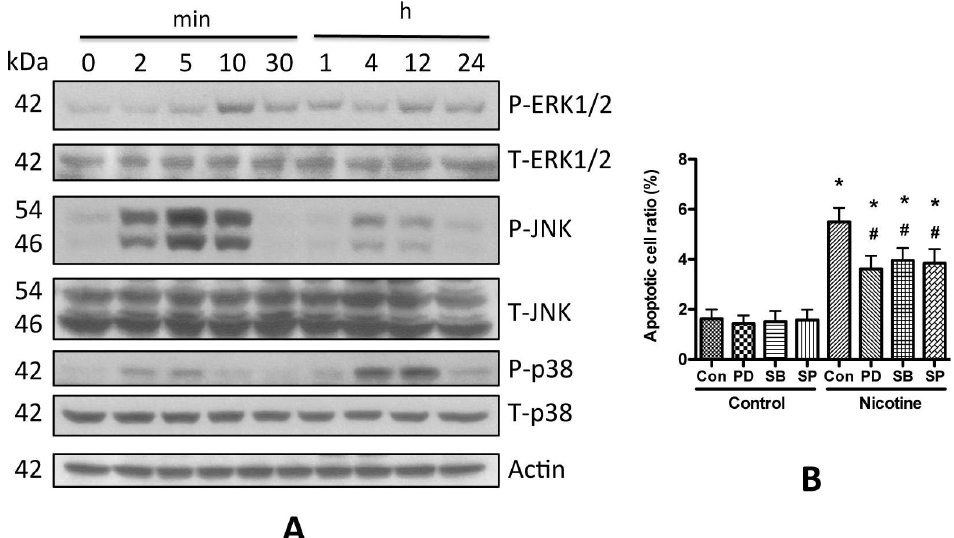
Fig 7. MAPKs regulated nicotine-induced podocyte apoptosis. A. Differentiated Human podocytes were starved in serum free medium for 12 h, and then 0.1 μ M nicotine was added.Cell lysates were collectedat different time points, and Western blotting was performed to detect the phosphor-ERK1/2, JNK, and p38. Total proteinsand actin were used as loading control. B . Human podocyteswere pretreatedwith of PD98059(PD, 5 μ M), SB203580(SB, 3 μ M), or SP600125(SP, 5 μ M) for 1 h before 10 μ M nicotine was added.After incubation at 37˚C for another 48 h, apoptotic cells were then determinedand counted by using Hoechst staining.Results (mean ± SD) were calculatedfrom 20 pictures of each treatment. * p < 0.05 compared with blank control, while# p < 0.05 comparedwith morphinetreatment